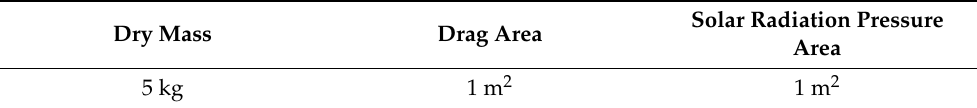
Table 1. Satellite characteristics for the ephemeris generation. Dry Mass